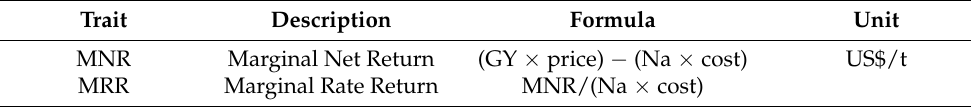
Table 2. Economic parameters of treatments (rate of nitrogen application). Trait